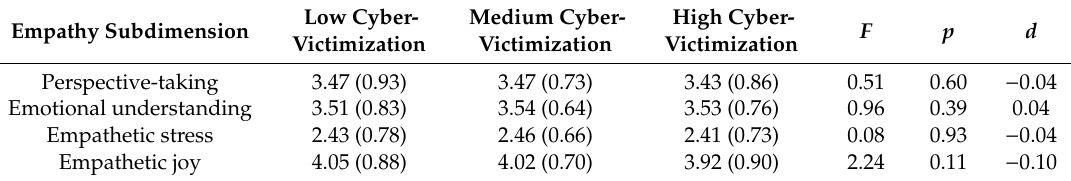
Table 4. Means, standard deviations (in parentheses), and results of the ANOVA of empathy for the groups of Low, Medium, and High